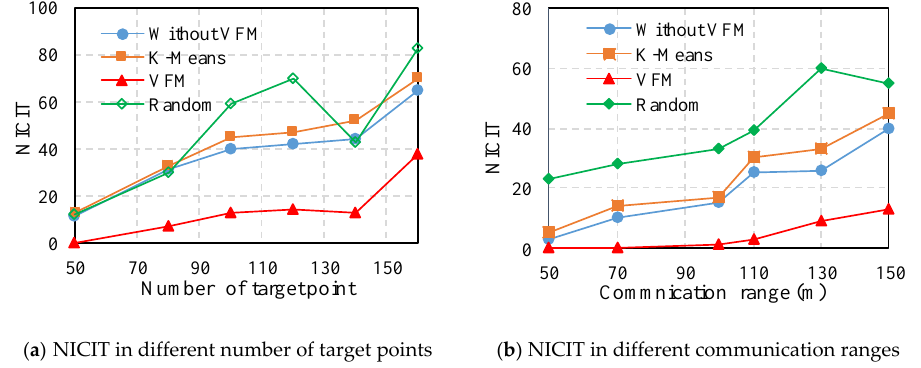
Figure 5. The results of NICIT in different methods.